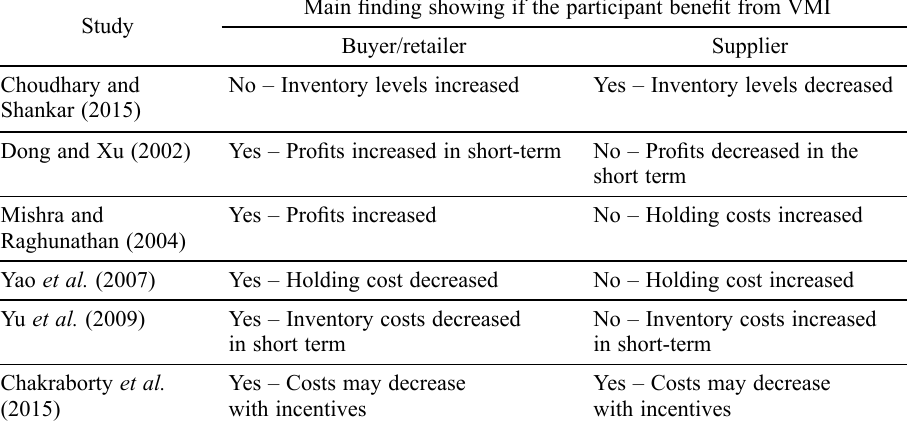
Table 1. Studies showing who benefits from